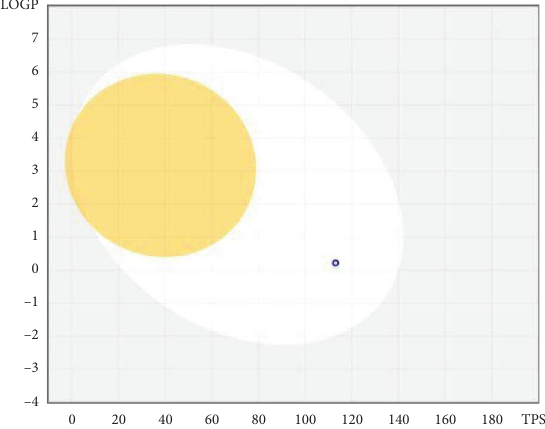
Figure 6: Boiled graph representation of Table 4: Pharmacokinetics of TZDs (C1–C5) derivatives calculated with SwissADME database. Ligands